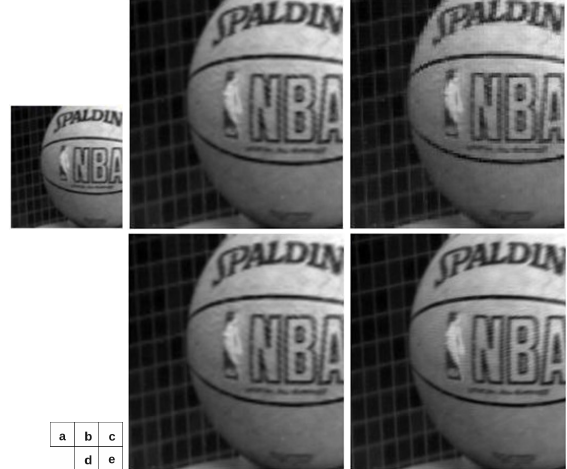
Figure 2: SR results on PCA-I of natural HS image for q = 2 (a) LR image of size 100 × 100 , (b) Bicubic interpolation, (c) CS based initial estimate, (d) Proposed approach, and (e) Groundtruth.